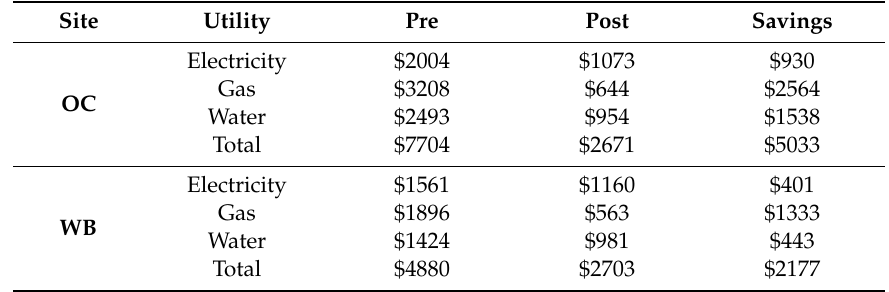
Table 4. Annual pre- and post-redevelopment costs from electricity, natural gas for heating and water consumption per